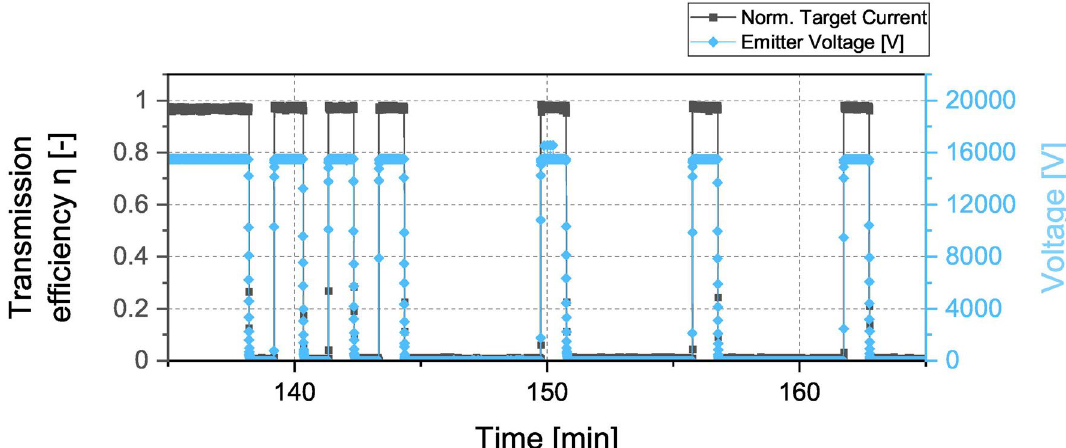
Figure 4. On–off tests with a 180° capillary. The black graph depicts the transmission current whereas the blue graph represents the applied acceleration voltage of the electron gun which indicates the turn on and turn off of the electron beam.